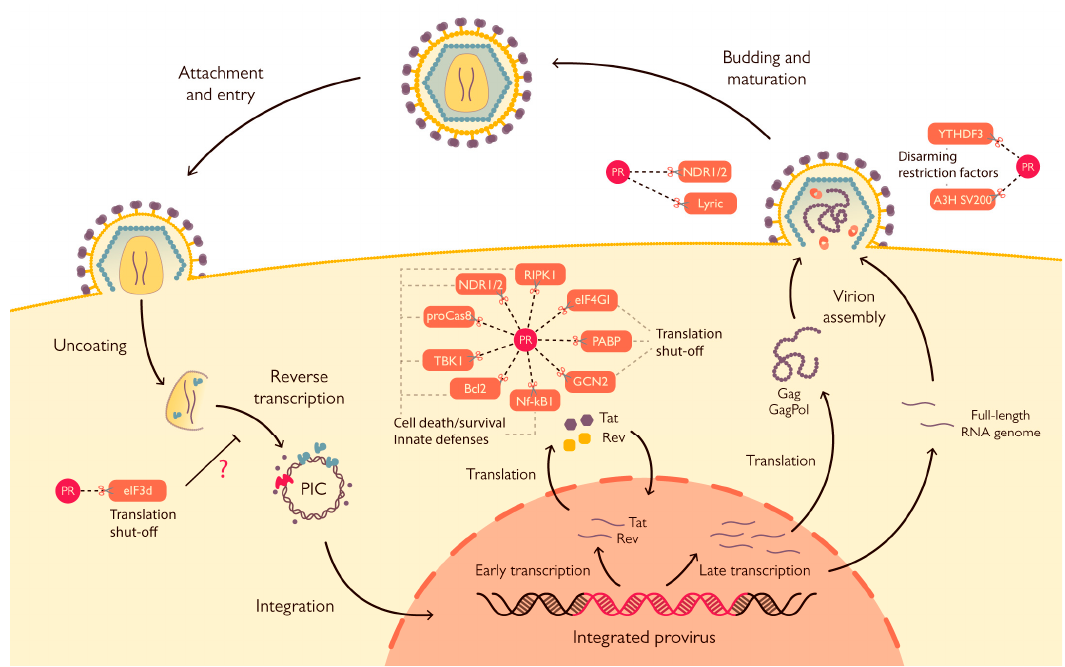
Figure 2. HIV-1 replication cycle with targets cleaved by HIV-1 protease. The exact timing and location of the activity of HIV-1 PR are still not completely characterized. It is speculated that due to its possible anti-RT activity, eIF3D may be an early target of PR, and inactivating this factor may serve as a way to escape antiviral defenses of the cell and hinder cap-dependent translation. The other intracellular targets are most likely cleaved by post-integration synthetized PR, among these targets there are several proteins involved in protein synthesis that are responsible for either cap-dependent translation initiation ( eIF4G , PABP ) or translation regulation ( GCN2 ). The other major protein cluster that is targeted by the viral enzyme represents proteins involved in cell death and the innate defenses of the cell ( Bcl2 , Procaspase8 , NF- κ B1 , NDR1/2 , RIPK1 , TBK1 ). Lastly, HIV-1 PR was shown to cleave host proteins that are incorporated into the nascent virion, two of which exert antiviral activity ( A3H SV200 , YTHDF3 ) while the specific function of the other two ( NDR1/2 , Lyric ) remain unknown.